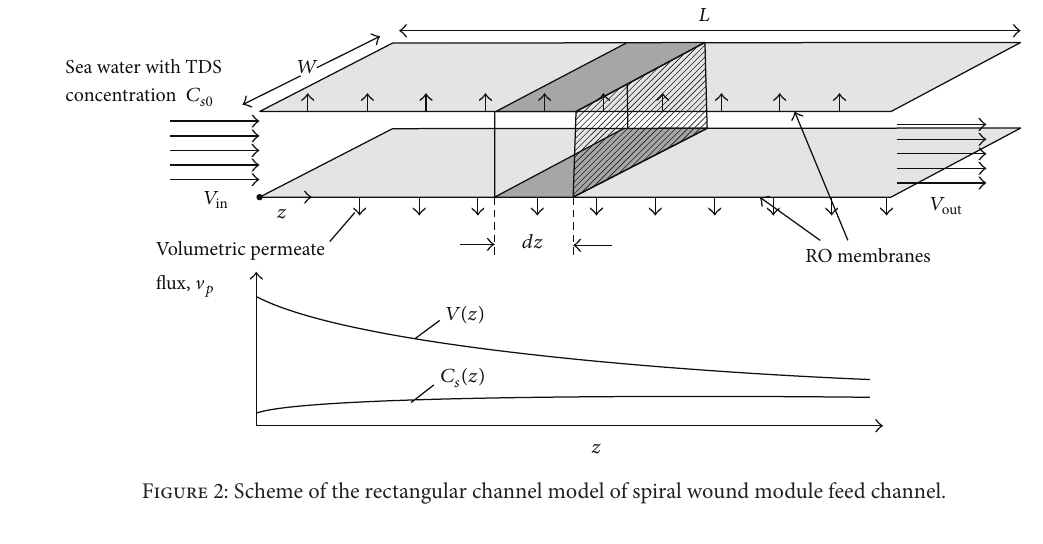
Figure 1: Detailed schematic diagram of RO process and water storage process.